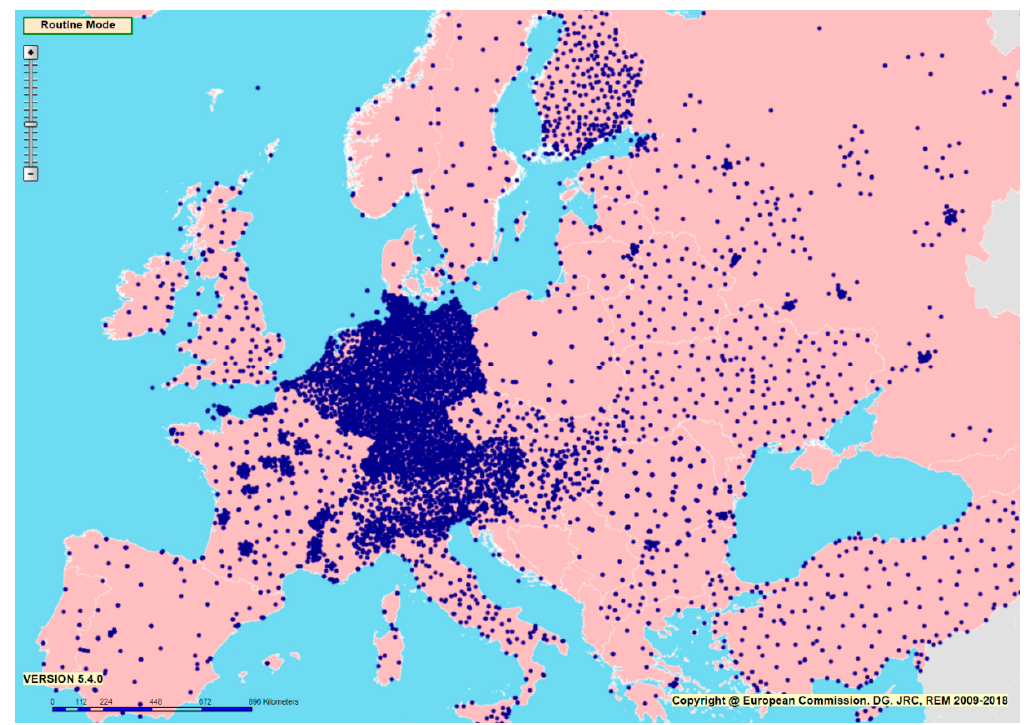
Figure 1. EURDEP map of European radioactivity monitoring stations. Source: http://eurdepweb.jrc.ec.europa.eu/EurdepMap/Default.aspx (Accessed on: 20 July 2018).